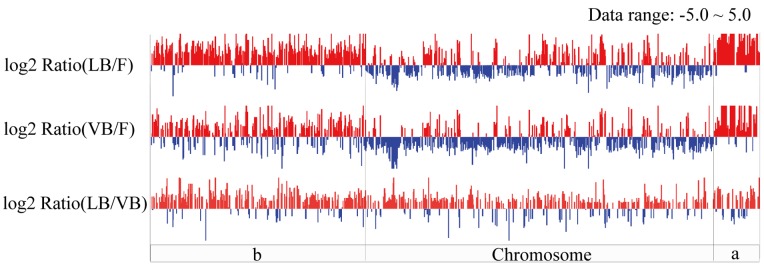
Distributions of differentially expressed genes across replicons of Sinorhizobium sp. NGR234.a, pNGR234a; b, pNGR234b; Chromosome, cNGR234; three replicons were separated by dashed lines. log2 Ratio(VB/F), the base 2 logarithm value for the ratio of expression level between bacteroids of Vigna unguiculata (VB) and free-living (F) Sinorhizobium sp. NGR234; LB/F, the ratio between L. leucocephala bacteroids and free-living bacteria; LB/VB, the ratio between L. leucocephala bacteroids and V. unguiculata bacteroids. The red bars above the horizontal line represent genes with the log2 Ratio values >1.0 whereas the blue bars below the horizontal line indicate genes with the log2 Ratio values<−1.0.